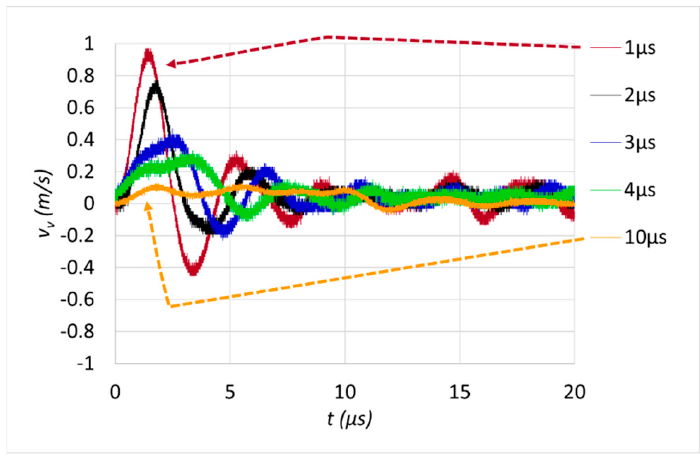
Figure 17. Measured transient vibration velocity waveforms at the top of the actuator.